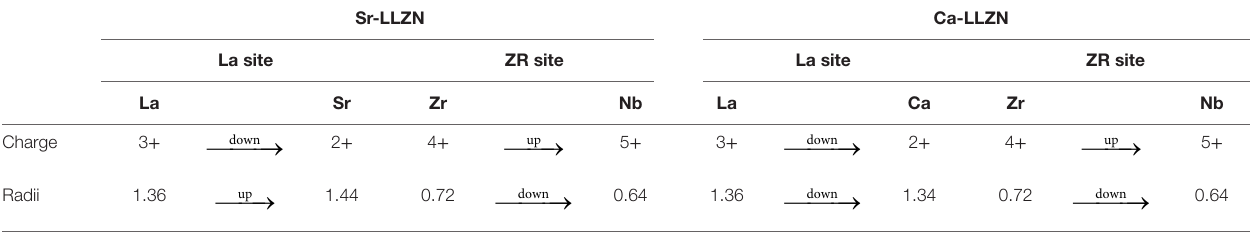
TaBle 2 | Valence numbers and ionic radii of elements substituted into the a-llZnb (a = sr or ca) series. sr-llZn ca-llZn la site Zr site la site Zr